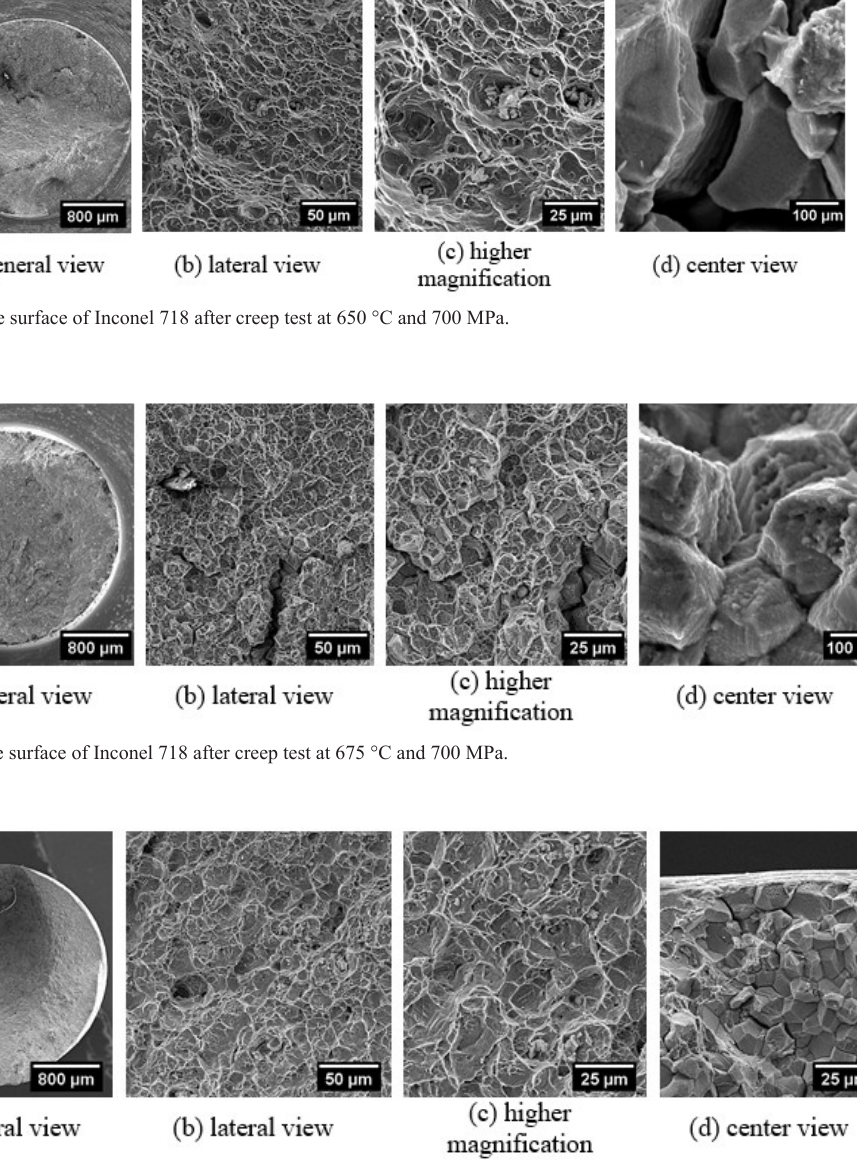
Figure 12. Fracture surface of Inconel 718 after creep test at 700 °C and 700